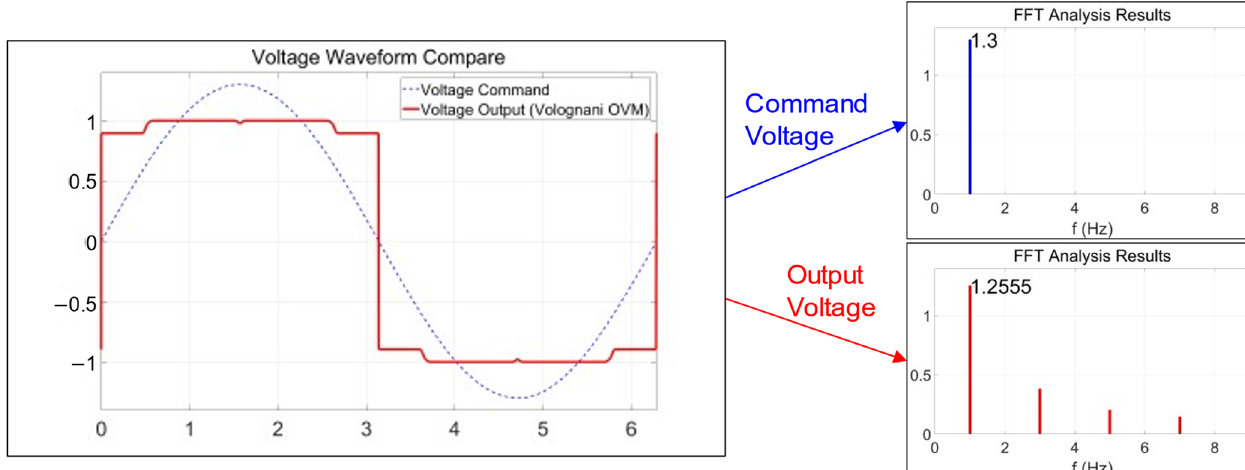
Figure 4. Comparison of magnitudes of fundamental frequency components of command voltage and output voltage.